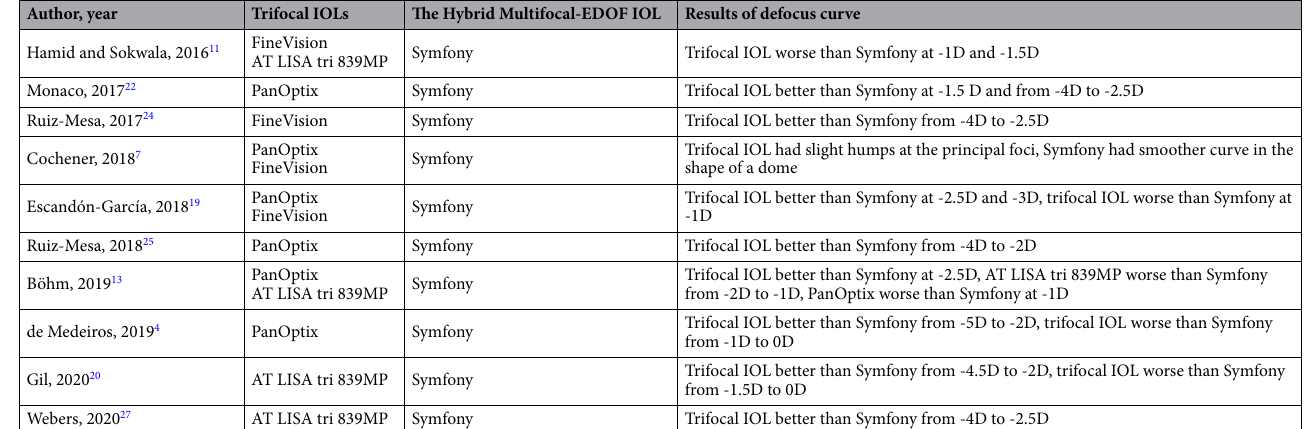
Table 2. Descriptive information of defocus curve. EDOF, extended depth of focus; IOL, intraocular